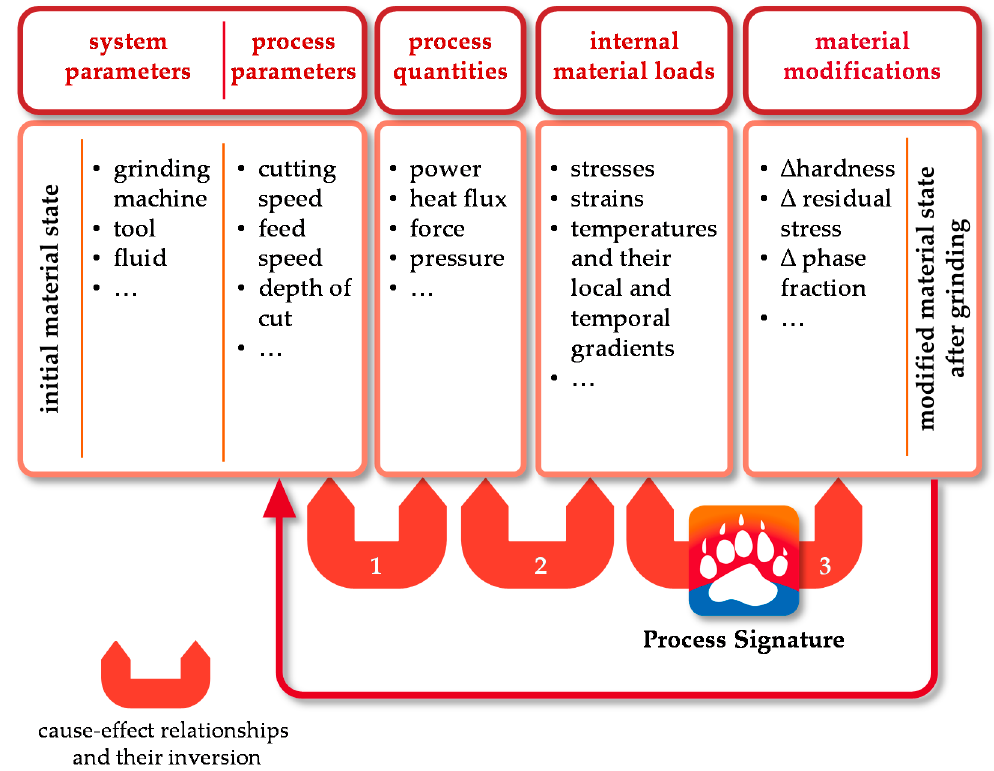
Figure 1. Cause-effect relationships according to the Collaborative Research Center SFB/TRR 136 “Process Signatures”. A nomenclature describing all symbols used in the paper is shown in Table